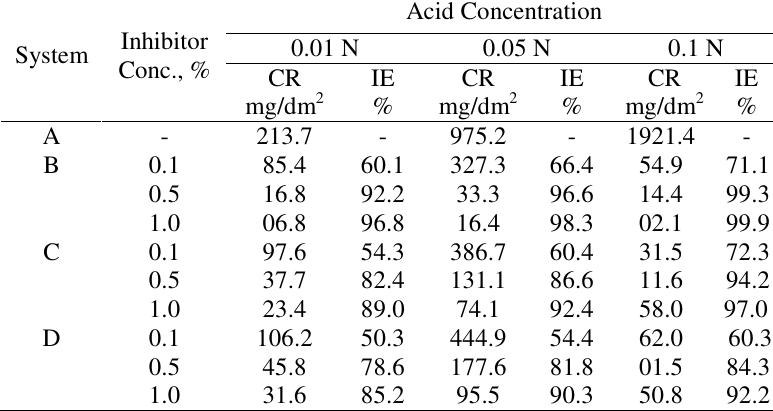
Table 1. Corrosion rate (CR) and Inhibition efficiency (IE) of zinc in (0.01 N HNO N H SO ), (0.05 N HNO 2 4 containing ethanolamines as inhibitors for an immersion period of 24 h at 301 + 1